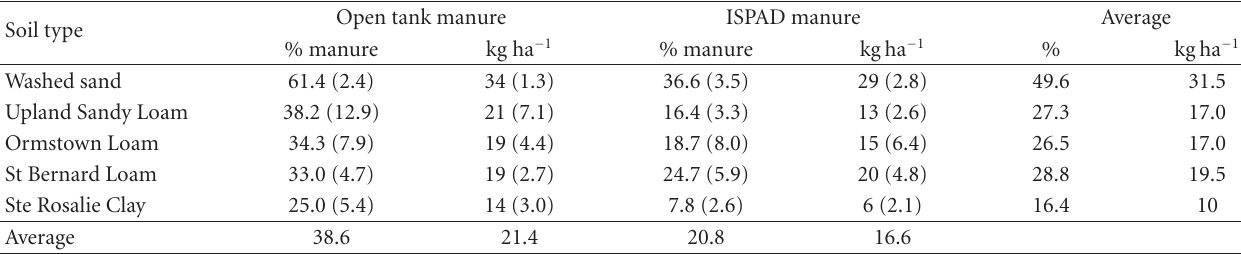
Table 3: Fraction of the manure TAN volatilized in 47 hours of wind tunnel simulations for the five experimental soils and two manures, untreated (open tank) and anaerobically digested